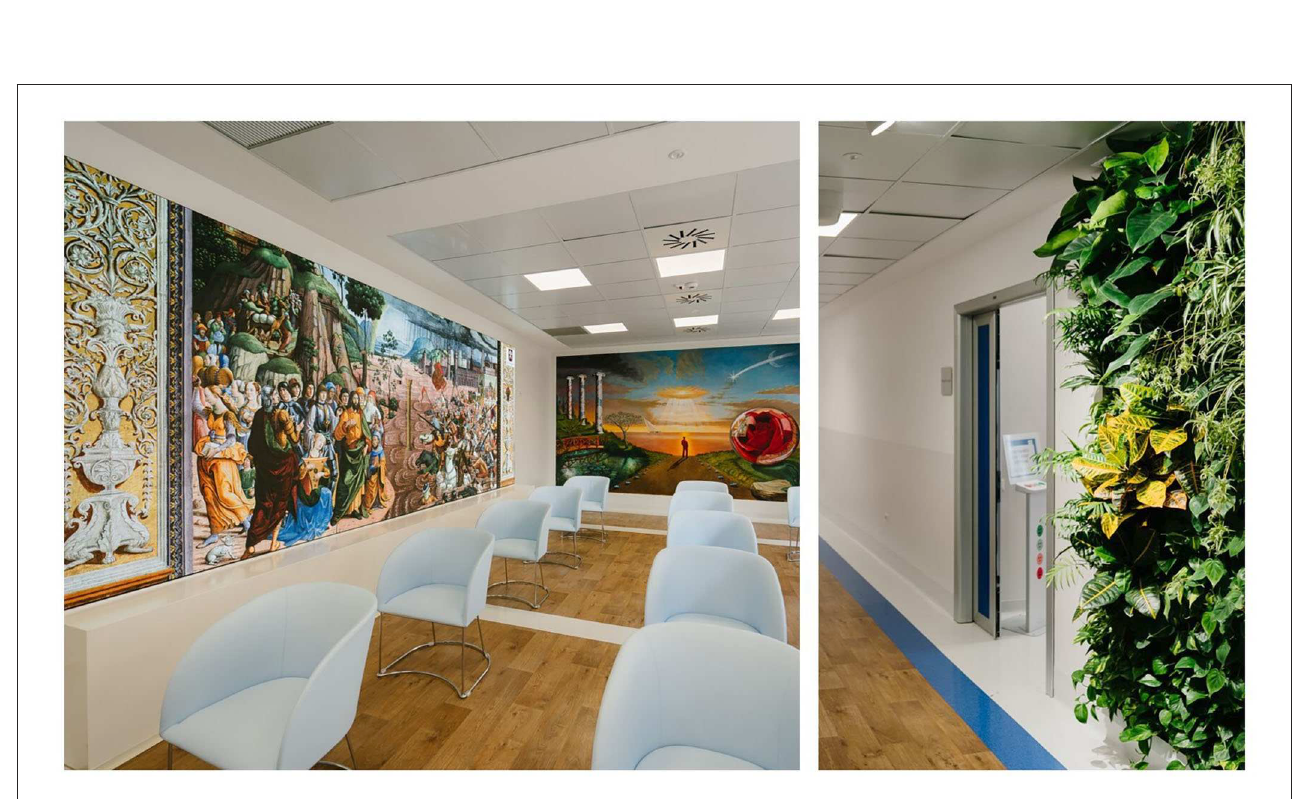
FIGURE6 Details of the common areas of the Art4ART